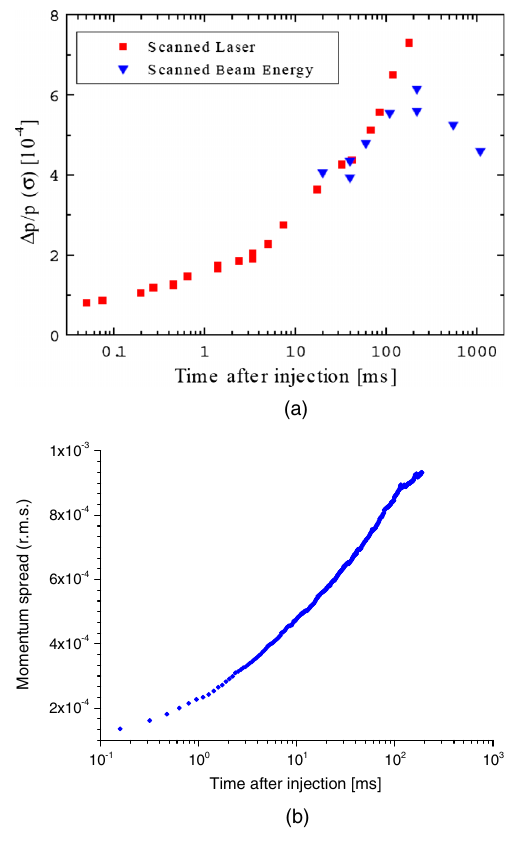
FIG. 9. Momentum spread of an 18 : 4 keV = A Mg þ beam as a function of time. The initial beam intensity is 2 : 7 (cid:6) 10 þ 7 ions: (a) experimental data taken from [14]; (b) BETACOOL simula- tions. Because of IBS the rms velocity spread increases from around dp=p ¼ 10 (cid:3) 4 at injection to dp=p ¼ 7 (cid:6) 10 (cid:3) 4 in about 200 (cid:12) s